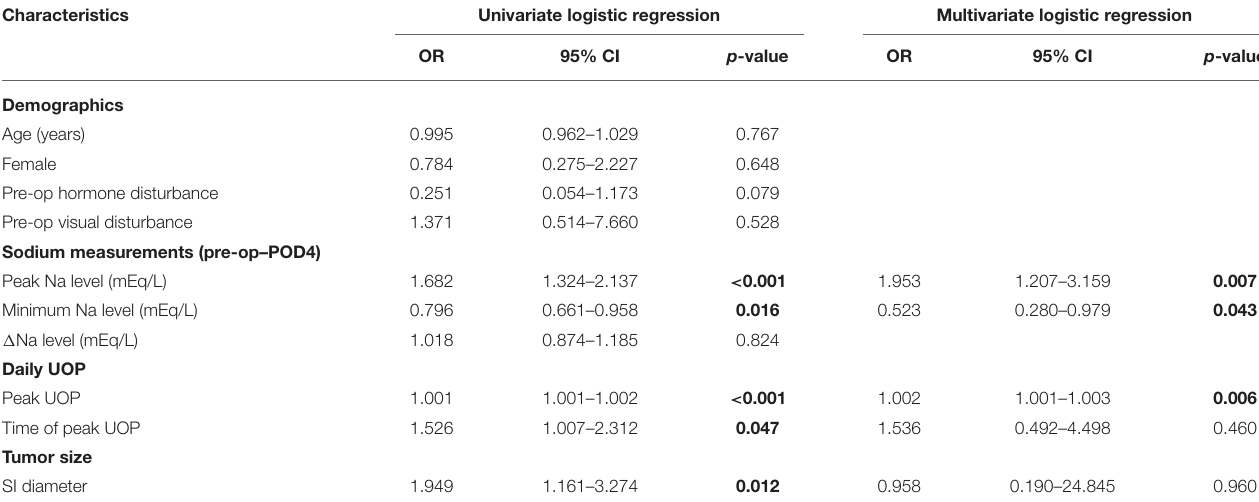
TABLE 2 | Logistic regression model of requiring any desmopressin use in patients with postoperative DI following EEA.